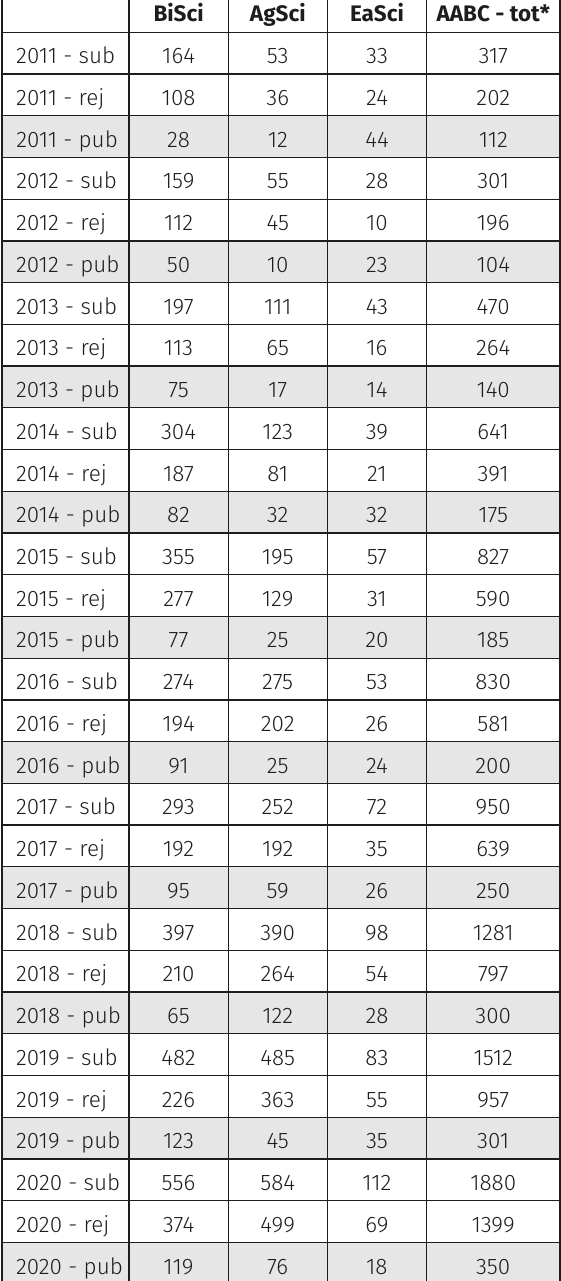
Table I. Manuscripts submitted, rejected, and published in Biological, Agrarian and Earth Sciences in the last decade in the Annals of the Brazilian Academy of Sciences.